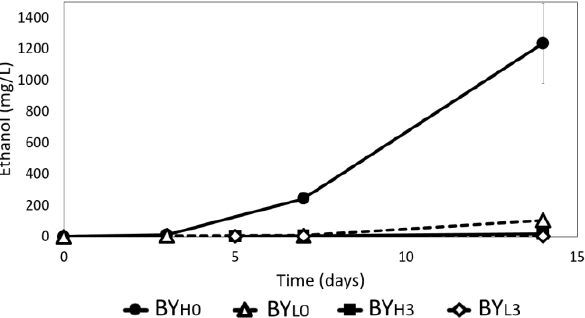
Figure 7. Ethanol production by D. bruxellensis during 14 days of co-culture with K. intermedius at 30 C. D. bruxellensis was added simultaneously at concentrations of 10 6 CFU/mL (BY H0 ) and 10 3 CFU/mL (BY L0 ) and sequentially at 10 6 CFU/mL (BY H3 ) and 10 3 CFU/mL (BY L3 ).